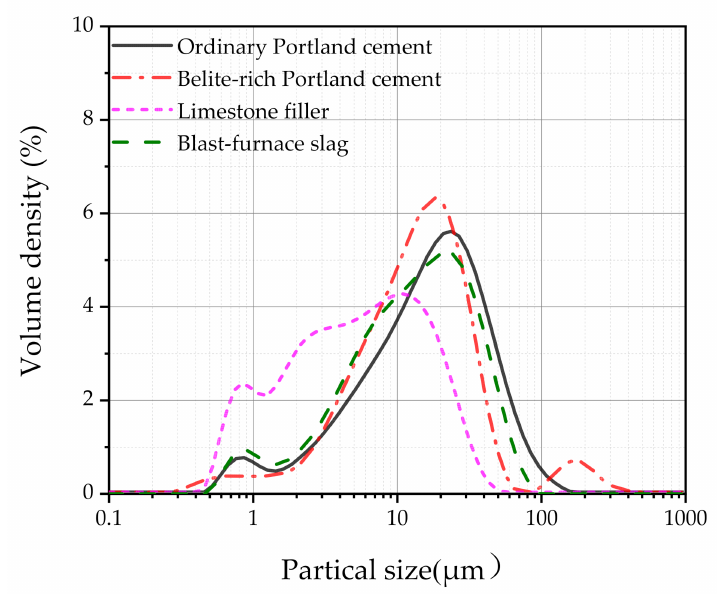
Figure 1. Particle size distribution of each component.